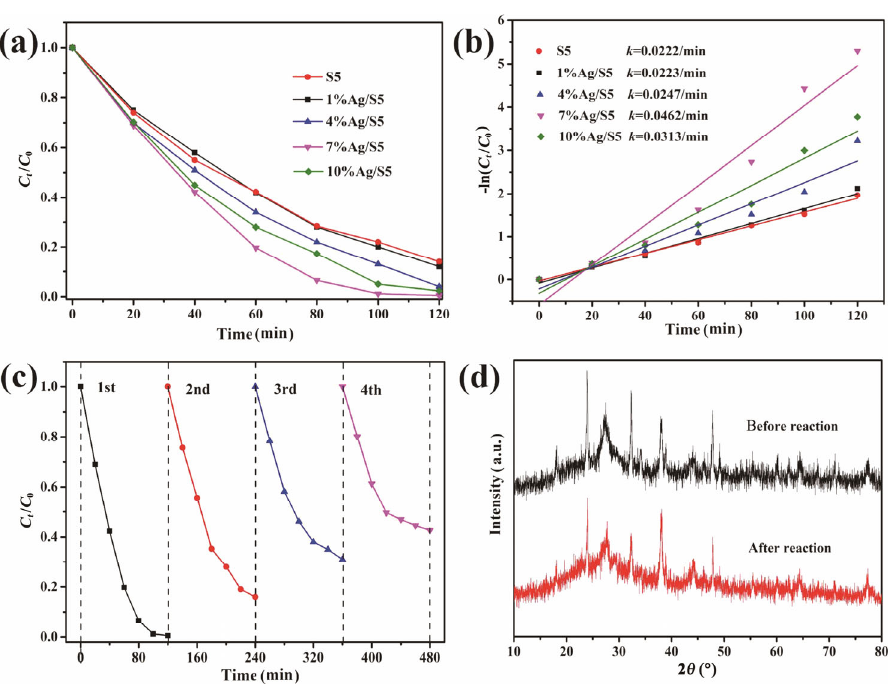
Fig. 5 (a) Photocatalytic activities of as-prepared ternary photocatalysts for MB degradation under visible light irradiation; (b) photocatalytic degradation kinetics of MB over all samples; (c) recycling experiments of photocatalytic degradation on 7%Ag/S5; (d) XRD patterns of 7%Ag/S5 before and after four-time recycling experiments.